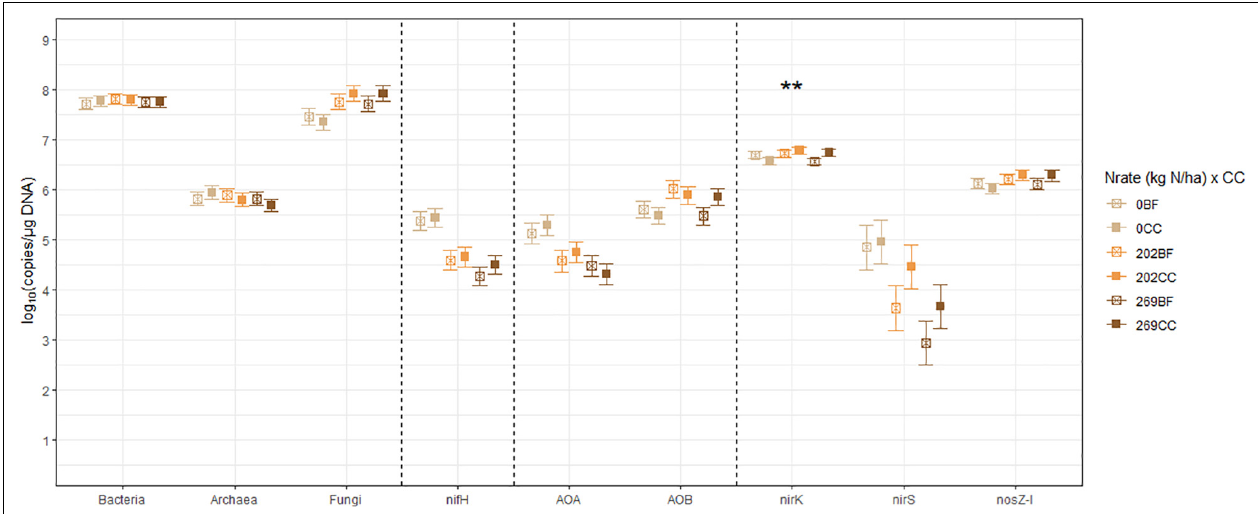
FIGURE 4 | The treatment means of soil microbial marker genes in (log 10 copies/ µ g DNA), including bacterial (Bacteria) and archaeal (Archaea) 16S rRNA, fungal ITS region (Fungi), nifH , archaeal (AOA) and bacterial (AOB) amoA , nirK , nirS , and nosZ-I separated by the interactions between N fertilization rate (Nrate) and cover cropping (CC), with their standard errors of the mean as whiskers. The asterisks indicate the probability value of the treatment effect from analysis of variance (** p < 0.05). Nrate treatment levels were: 0, 202, and 269 kg N/ha. CC treatment levels were bare fallow control (BF) and hairy vetch and cereal rye cover crop mixture